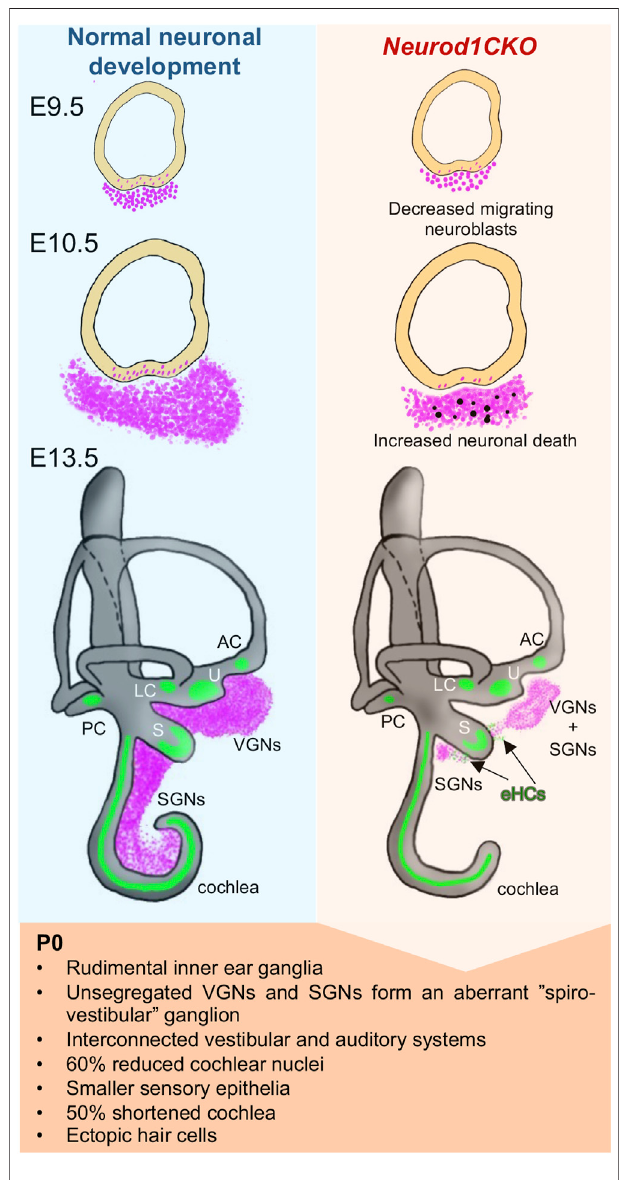
FIGURE 11 | Schematics of changes induced by the elimination of Neurod1 intheinnerear.Absenceof Neurod1 resultsinreduceddelamination and increased apoptosis of neuroblasts at E10.5. Remaining post-mitotic neurons form a misplaced rudimental spiral ganglion and diminished vestibular ganglion ( “ spiro-vestibular ” ganglion), containing unsegregated vestibular and cochlear neurons that extend unsegregated peripheral and central projections, resulting in circuits interconnecting peripheral sensory organs and brain nuclei of both the auditory and vestibular systems. The reduced afferent input from the cochlea affects the size of the cochlear nucleus of the brain stem in Neurod1CKO mice. Additionally, Neurod1 elimination results in smaller sensory epithelia, a loss of more than the half size of the cochlea, disorganization of sensory cells, multiple rows of inner and outer hair cells, trans-differentiation of outer hair cells in the apex, and generation of ectopic hair cells (eHCs) in the areas of inner ear ganglia.